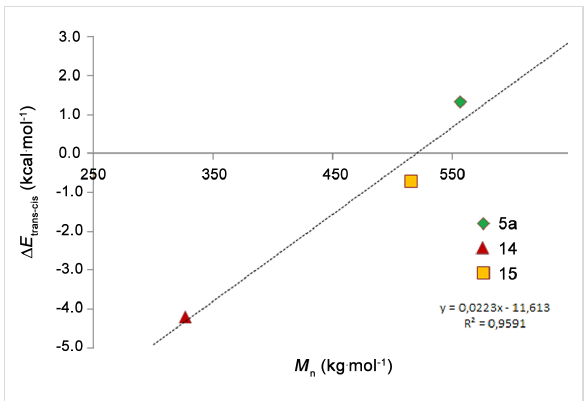
Figure 8: Number-average molecular weight ( M n ) of poly- 21 prepared with initiators 5a , 14 and 15 plotted against the theoretically deter- mined difference of trans–cis energies (solvation model PCM, solvent